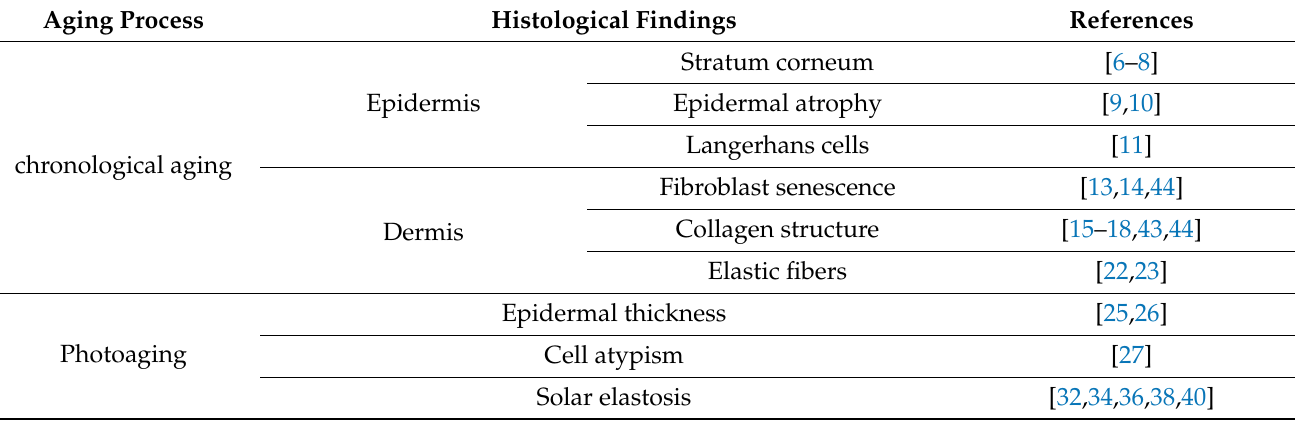
Table 1. Histology of chronological aging and photoaging with supporting studies. Aging